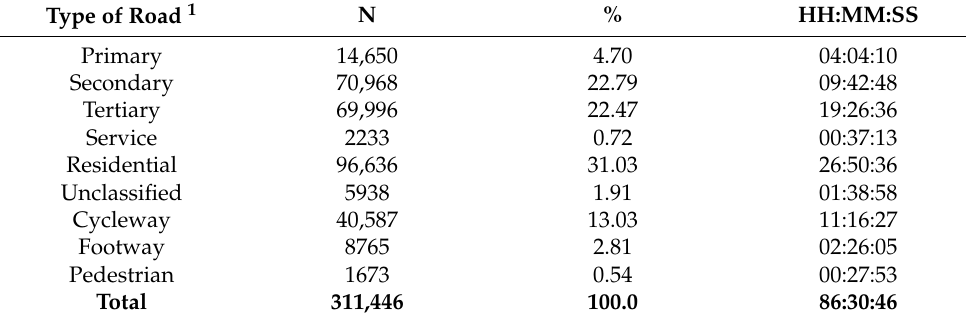
Table 1. GPS points and road